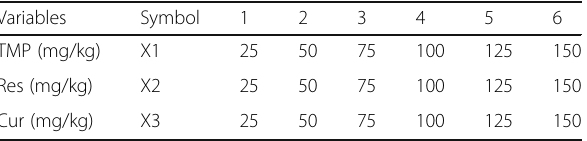
Table 1 Uniform Design table (3 factors, 6 levels) Variables